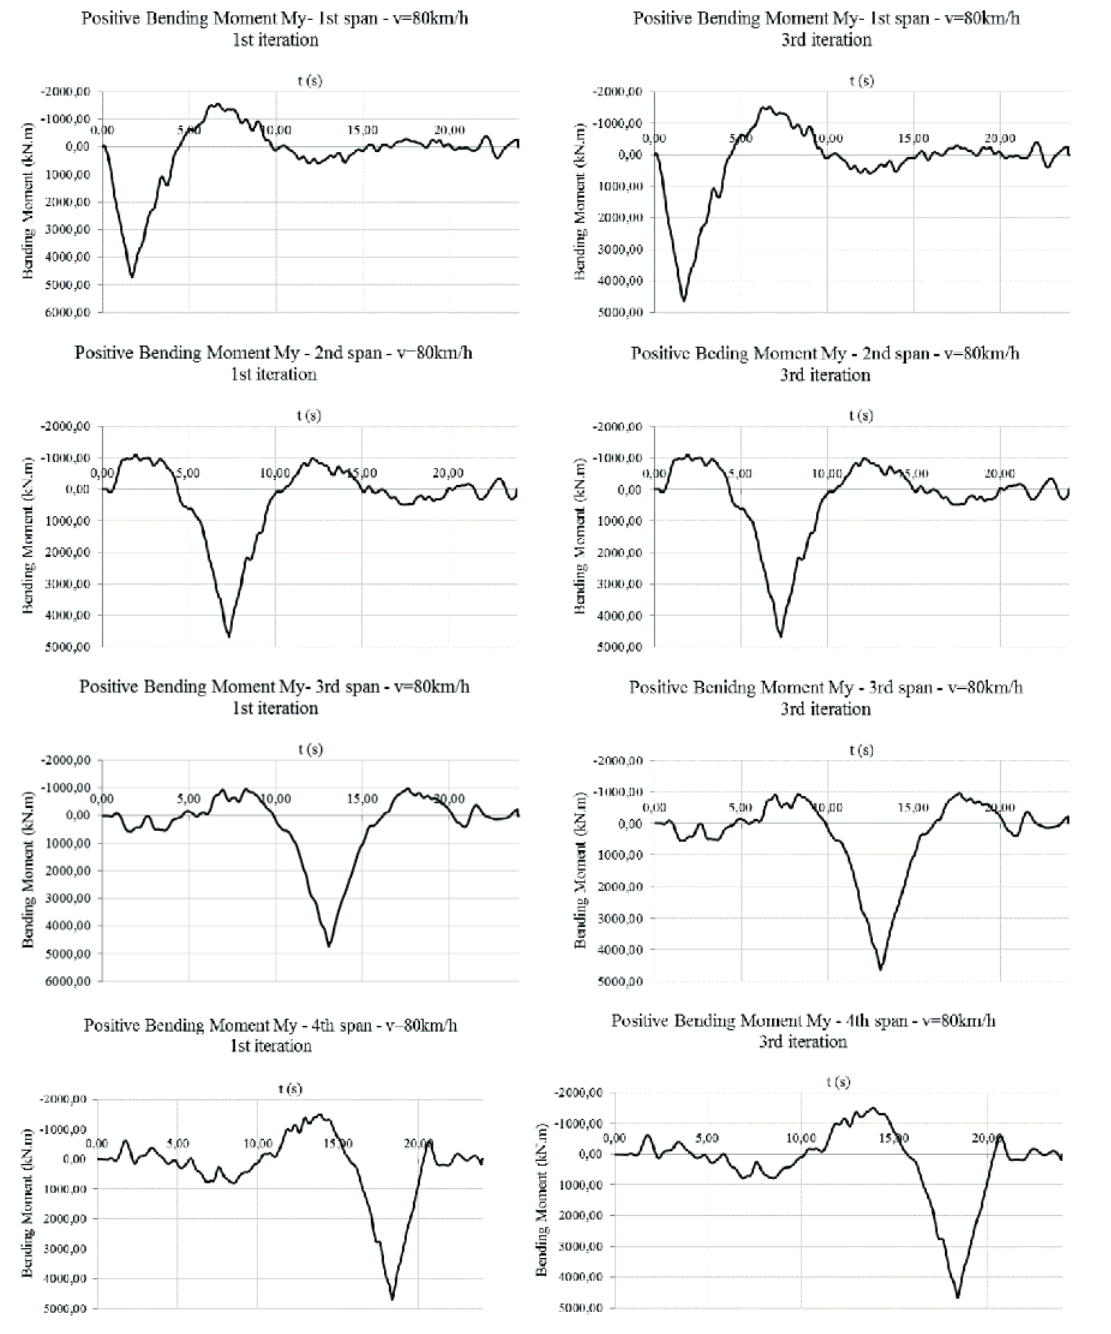
Comparison of the positive bending moments My for the 1 st and 3 rd iteration –